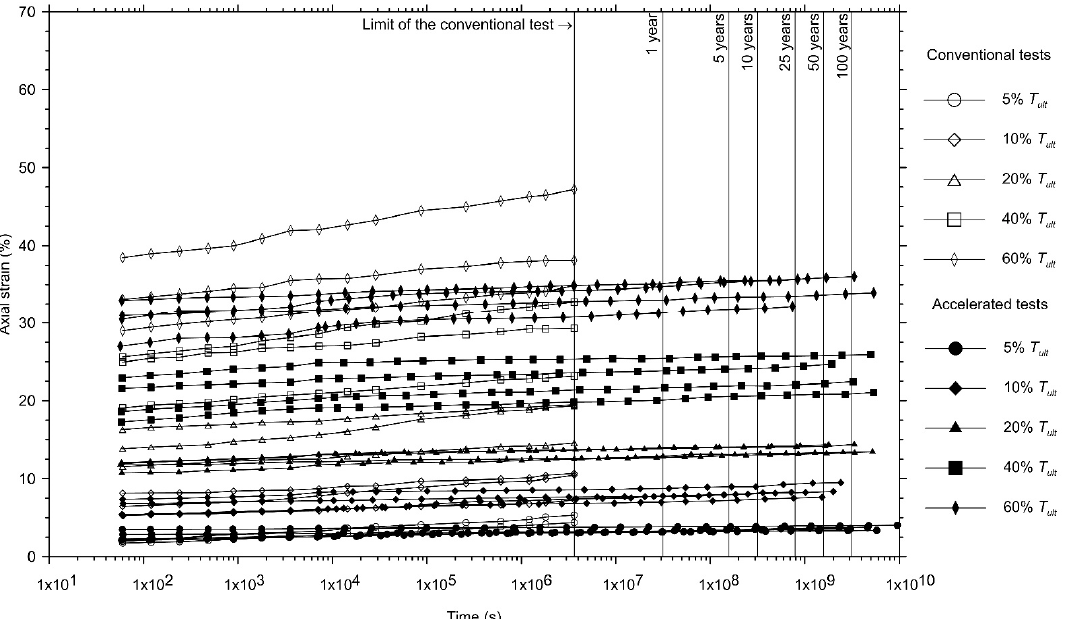
Figure 2. Comparison between the creep curves obtained using conventional creep tests and the master curves obtained by the accelerated creep tests for the non-woven needle-punched geotextile manufactured with continuous filament yarns (GTXnwC).